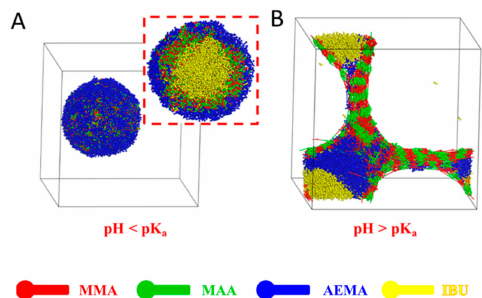
Figure 7. Morphologies of IBU-loaded system self-assembled from amphiphilic block copolymer poly(MMA 30 - co -MAA 33 )- b -PAEMA 28 together with IBU (6%) after incubation at di ff erent pH values ( A ) pH < p K a , ( B ) pH > p K a .